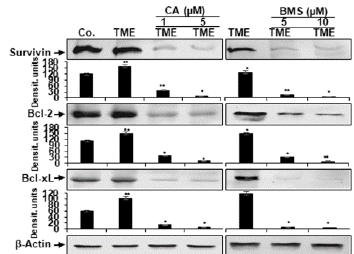
Figure 6. Effect of Calebin A (CA) or specific IKK inhibitor BMS-345541 on the expression of anti-apoptotic gene products in CRC cells: Serum-starved HCT116 cells in alginate cultures from multicellular pro-inflammatory TME cultures were treated as described in Materials and Methods.